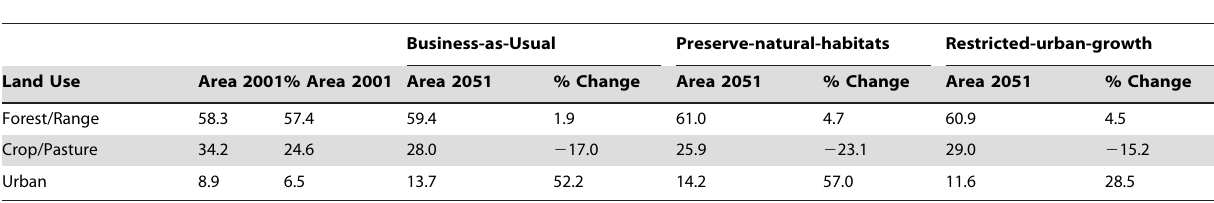
Figure 2. Box plots showing the variability in each land use across the scales of analysis for different land-use classes (row 1), and the maximum difference among scales in proportion of land in each use around the National Wildlife Refuges (row 2). Plots in row 2 compare conditions in 2001 (in white) with those in 2051 for each scenario (BAU=business-as-usual, PNH=preserve-natural-habitats, RUG=restricted-urban-growth). doi:10.1371/journal.pone.0055737.g002 Table 2. Land area (million ha) and percent areain different land uses within 25 km of the National Wildlife Refuges in 2001 and 2051 under each